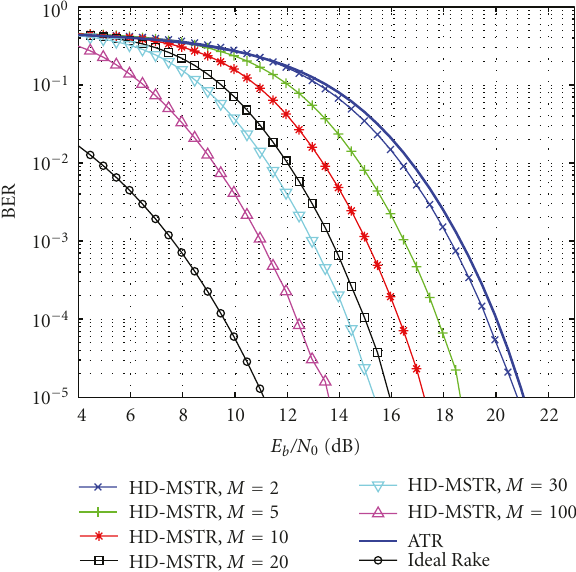
Figure 7: Average BER of HD-MSTR for di ff erent M over random channels, N = 10